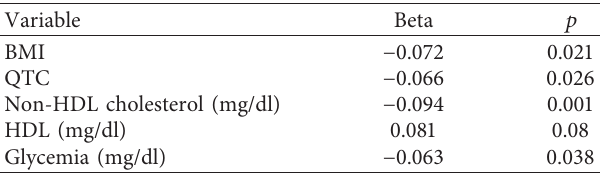
Table 6: Multivariate analysis. Multiple linear regression model (stepwise procedure) without metabolic syndrome score: 25(OH)D as the dependent variable and body mass index (BMI), systolic blood pressure, LDL cholesterol, non-HDL cholesterol, glycemia, CRP, C3, and